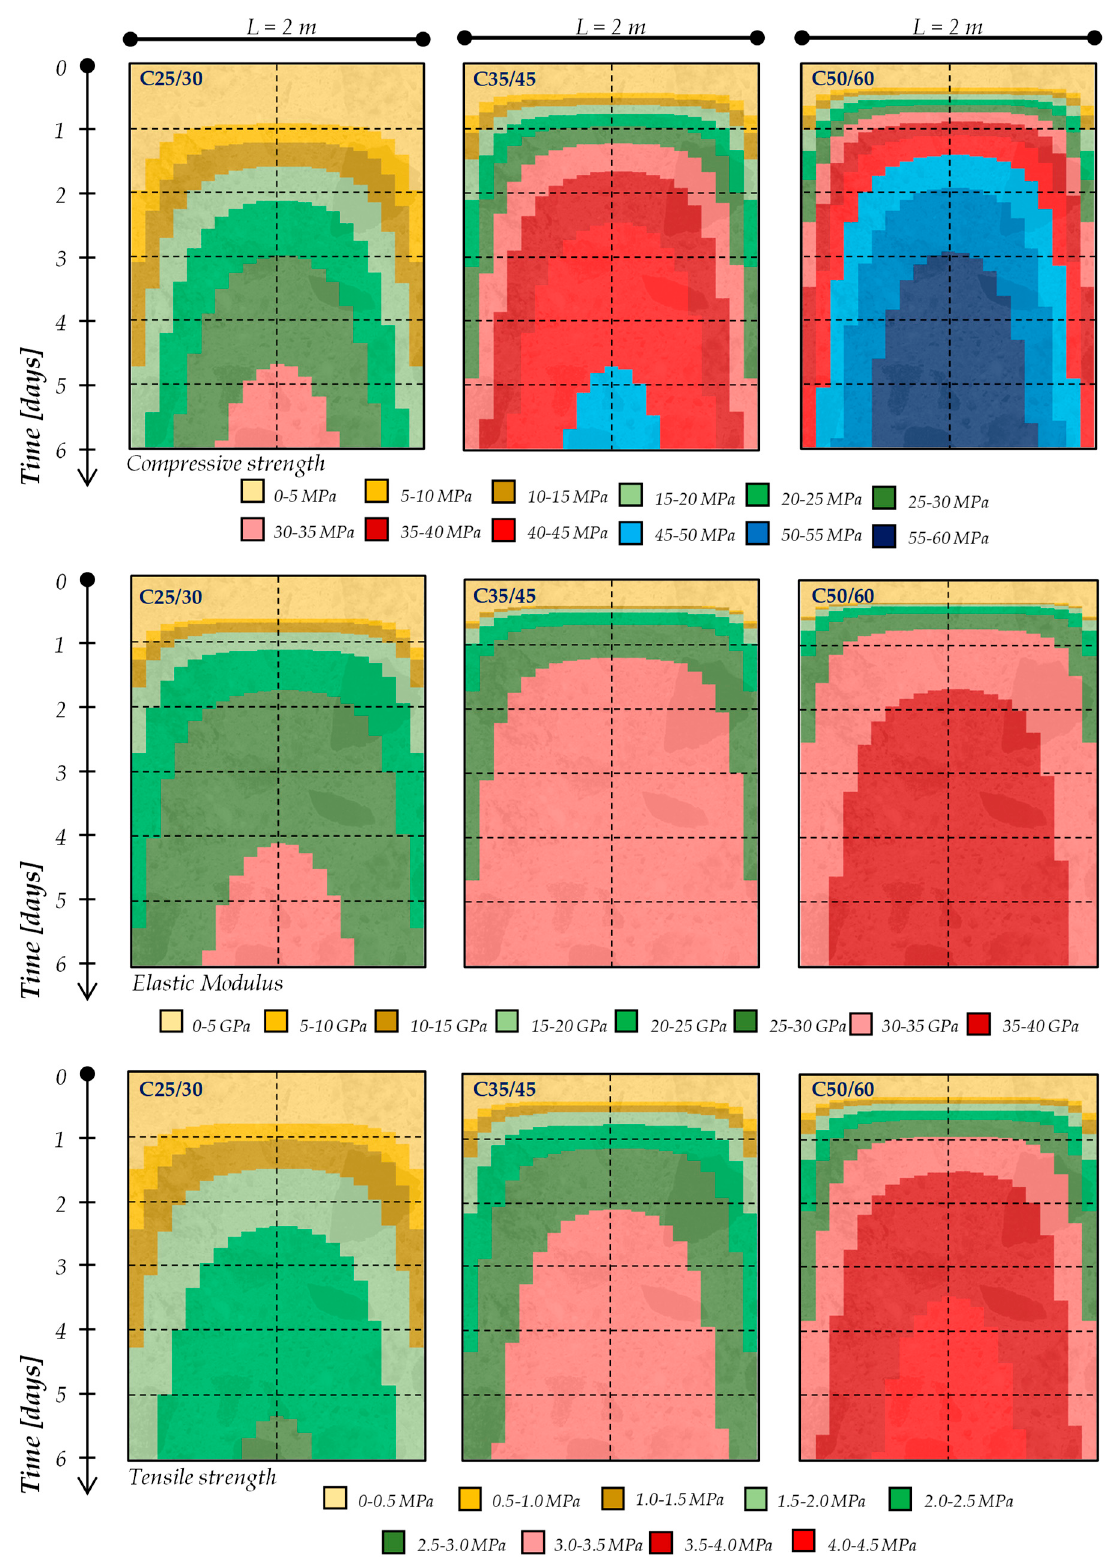
Figure 11. Early-age mechanical properties of 2-m thick concrete elements.